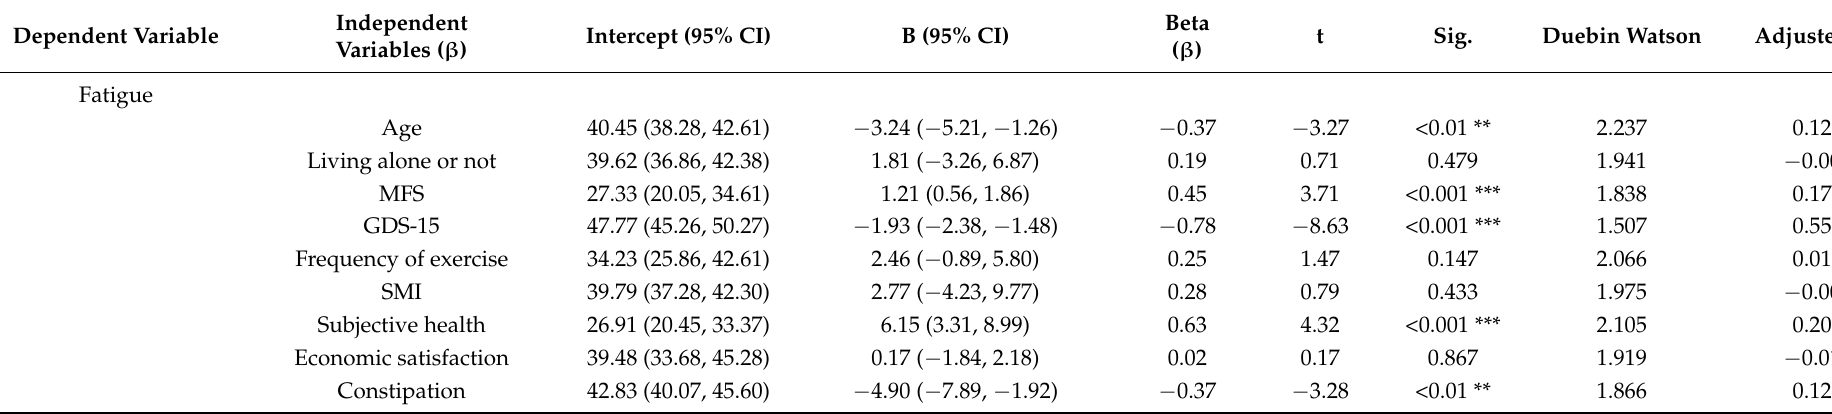
Table 3. Relationship between pull factor and